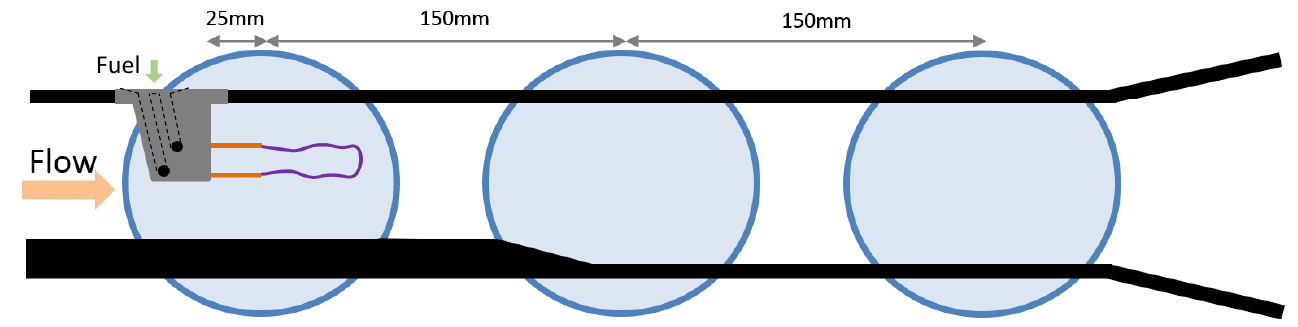
Figure 1. Test section with pylon installed.